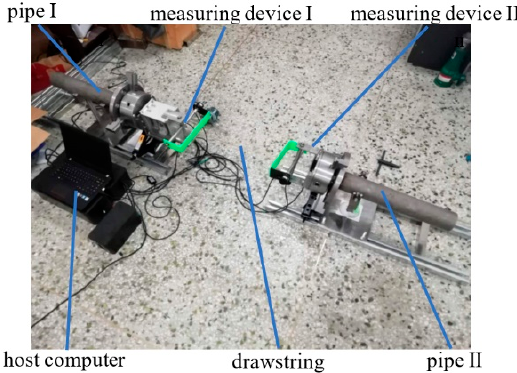
Figure 9. Measuring device based on flange center positioning.